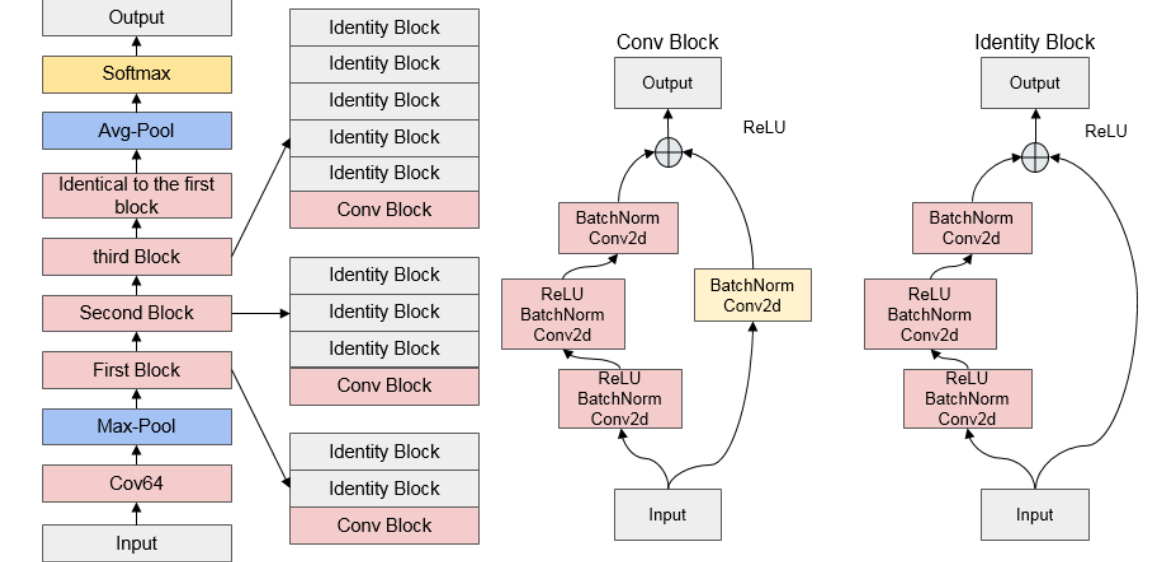
Figure 6. Schematic diagram of ResNet50 architecture.